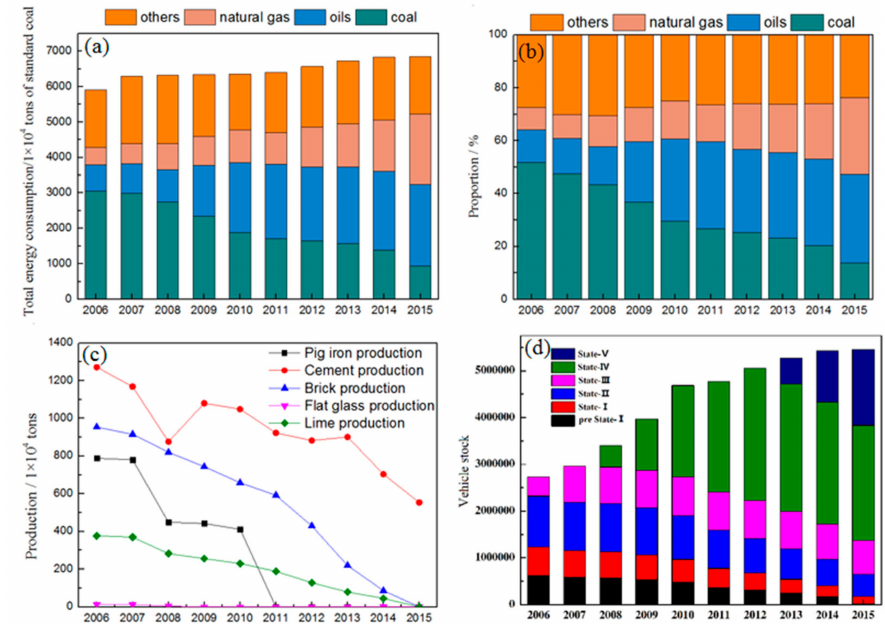
Figure 1. Annual variations of activity levels of primary pollution source from 2006 to 2015,